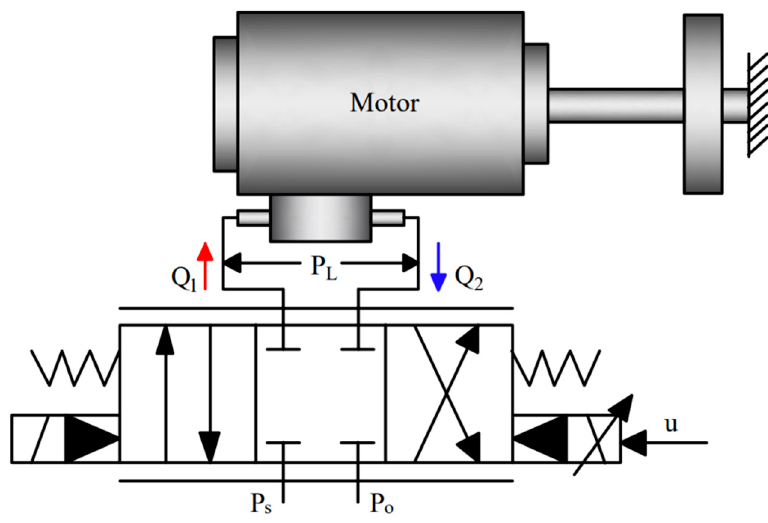
Figure 1. Electro-hydraulic servo systems model.